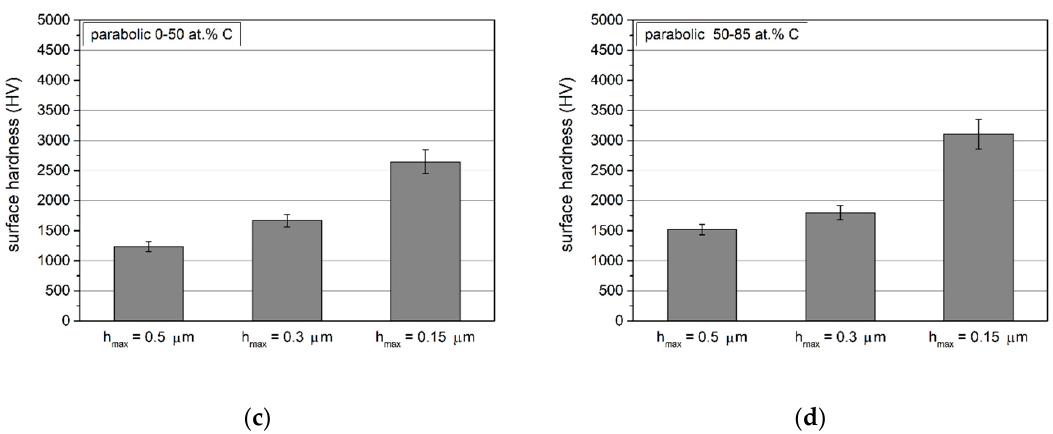
Figure 10. Surface hardness of coatings with three different maximum loads causing indentations of 0.15, 0.30 and 0.5 μ m: ( a ) square root carbon content variation profile in the range of 0–50 at.%, ( b ) square root carbon content profile in the range of 50 to 85 at.%, ( c ) parabolic carbon content profile in the range of 0–50 at.%, ( d ) parabolic carbon content profile in the range of 50 to 85 at.%.